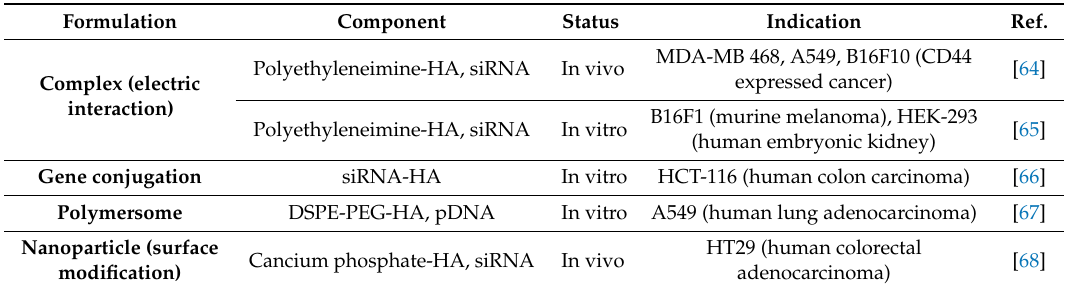
Table 2. Summary of recent principal research for gene therapy using HA-based